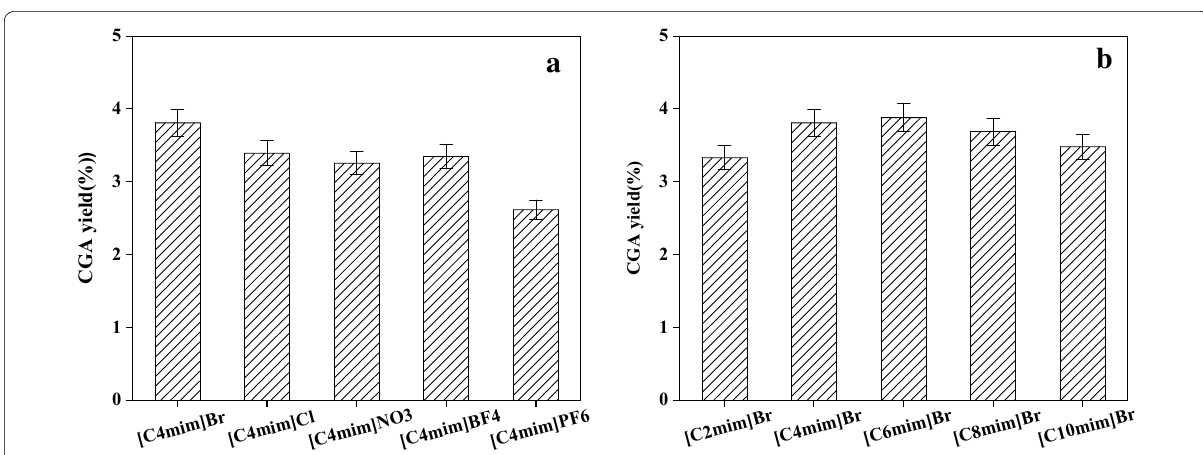
Fig. 2 Effect of ionic liquid anions ( a ) and cations ( b ) on the extraction yields of CGA from